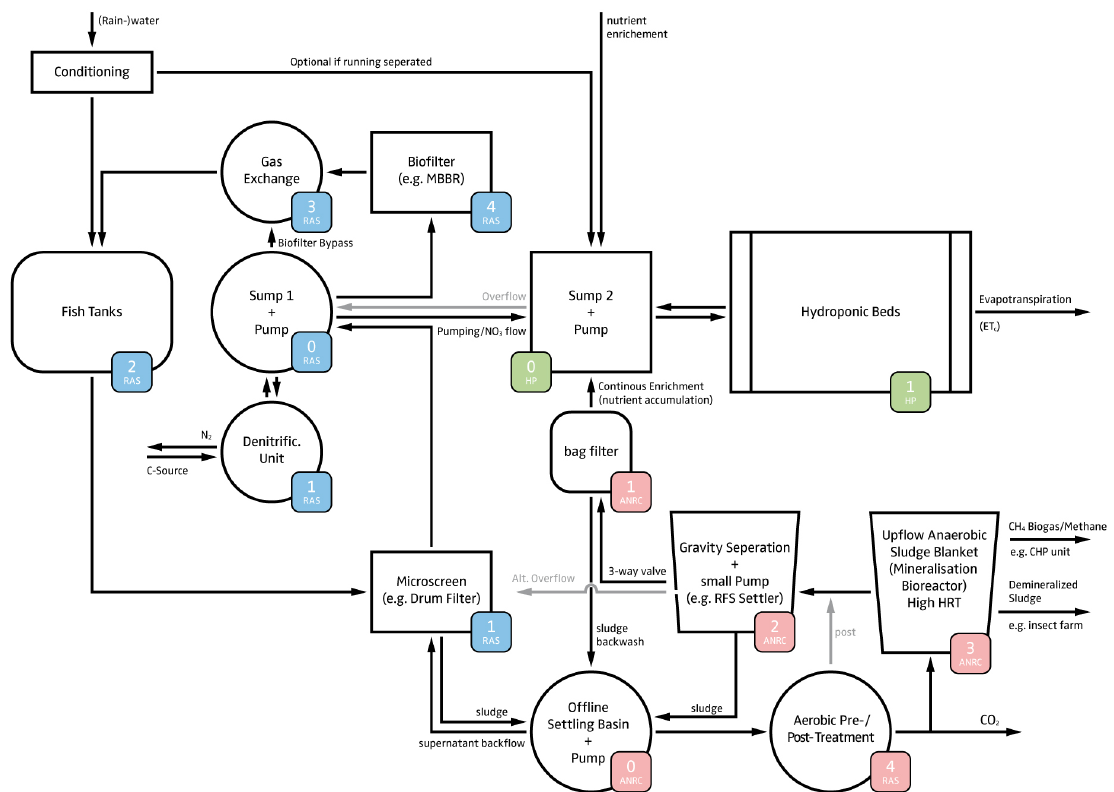
Figure 3. Process flow drawing of a basic DAPS layout. The blue tags comprise the RAS component, the green tags the hydroponic component, and the red tags the ANRC components. The level of each component is illustrated numerically in the small box and refers to the vertical direction the flow needs to travel to; whereas high numbers refer to high positioning and low numbers to low positioning. Gravity flow occurs, when water flows from high levels to low levels, and pressurized flow is required when the flow goes from low to high